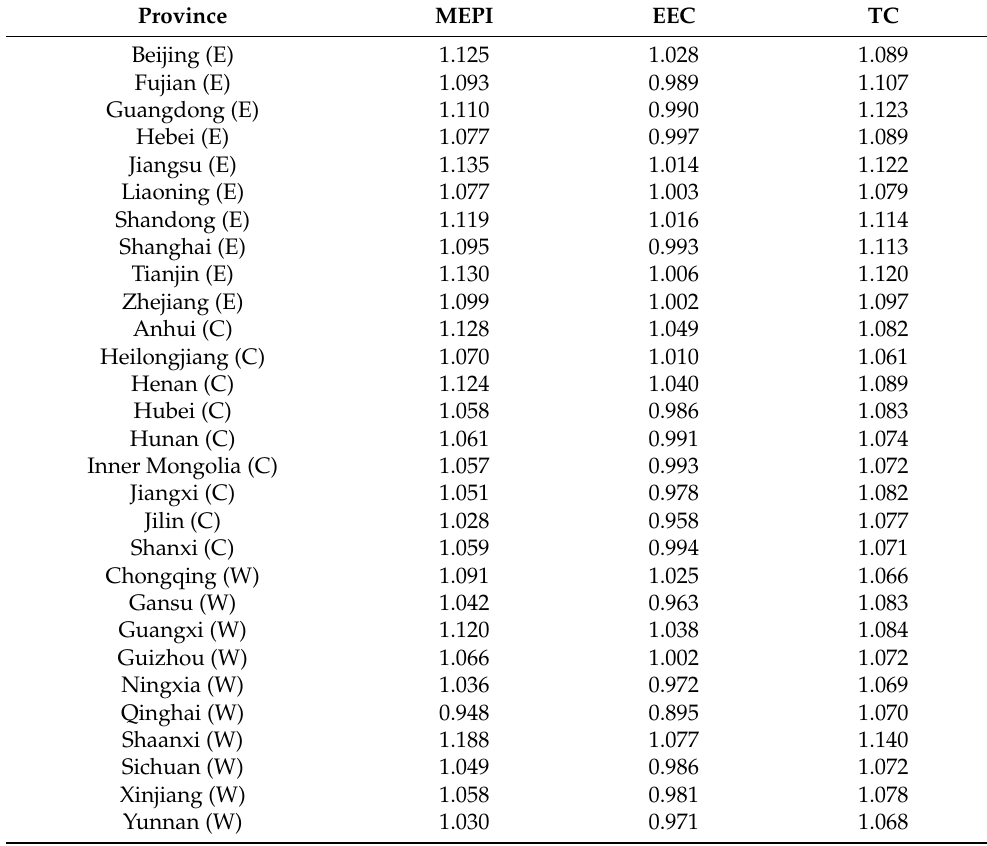
Table 2. Dynamic energy efficiency and its decompositions of ISI